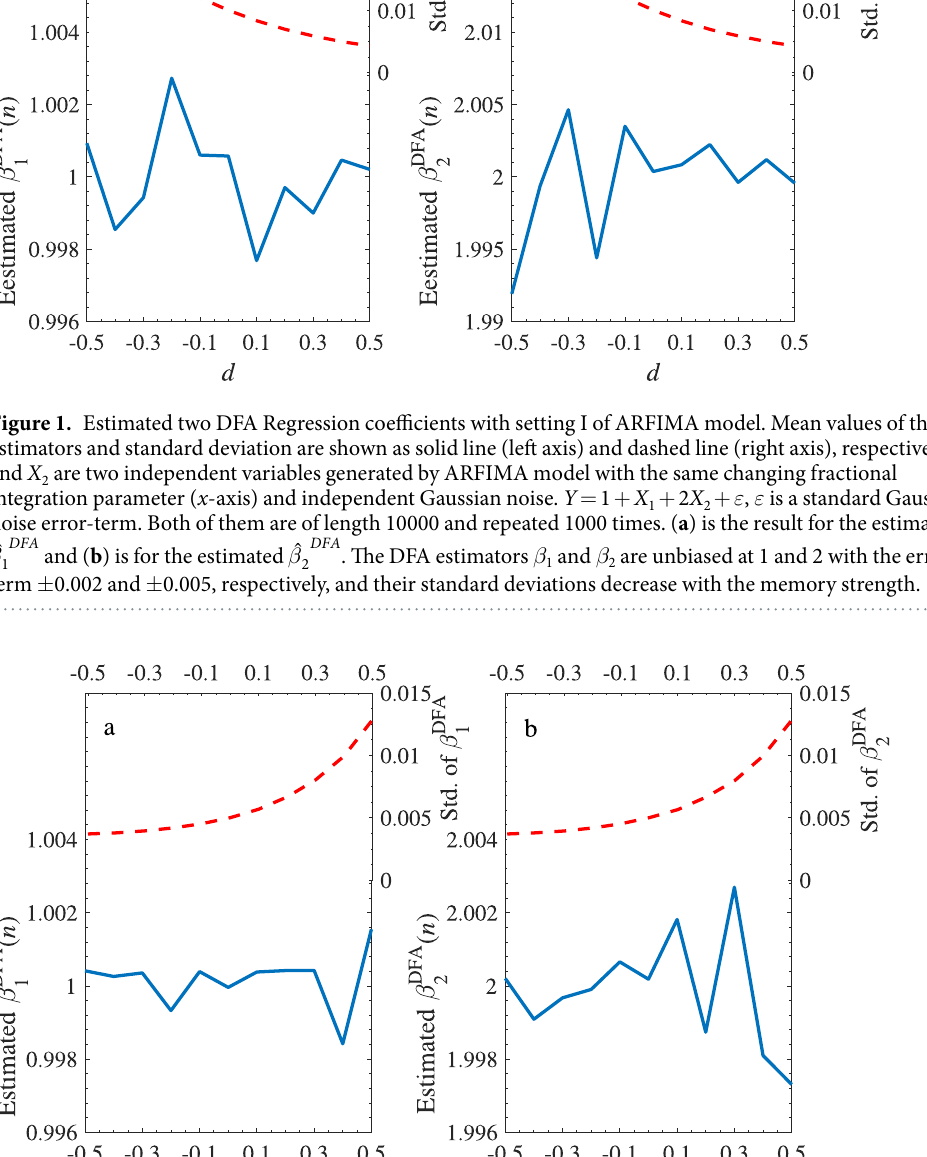
the method is feasible. On the other hand, to investigate the performance of the DFA estimators faced with a long-range dependent error-term ε , we use setting II given as: the memory parameter d is fixed at 0.4 for both X 1 and X 2 , and the ε is produced by an ARFIMA process with d ε varying from − 0.5 to 0.5. Other settings are as those in setting I. Figure 2 records similar information as that in Fig. 1. Although the fluctuation of DFA estimators increases with d ε , which is expected due to an increasing weight of the error-term in the dynamics of Y with the increasing memory of the error-term, we are satisfied to find that the two estimators are still unbiased pointing to the given values with a narrow range for each level of memory of the error-terms.